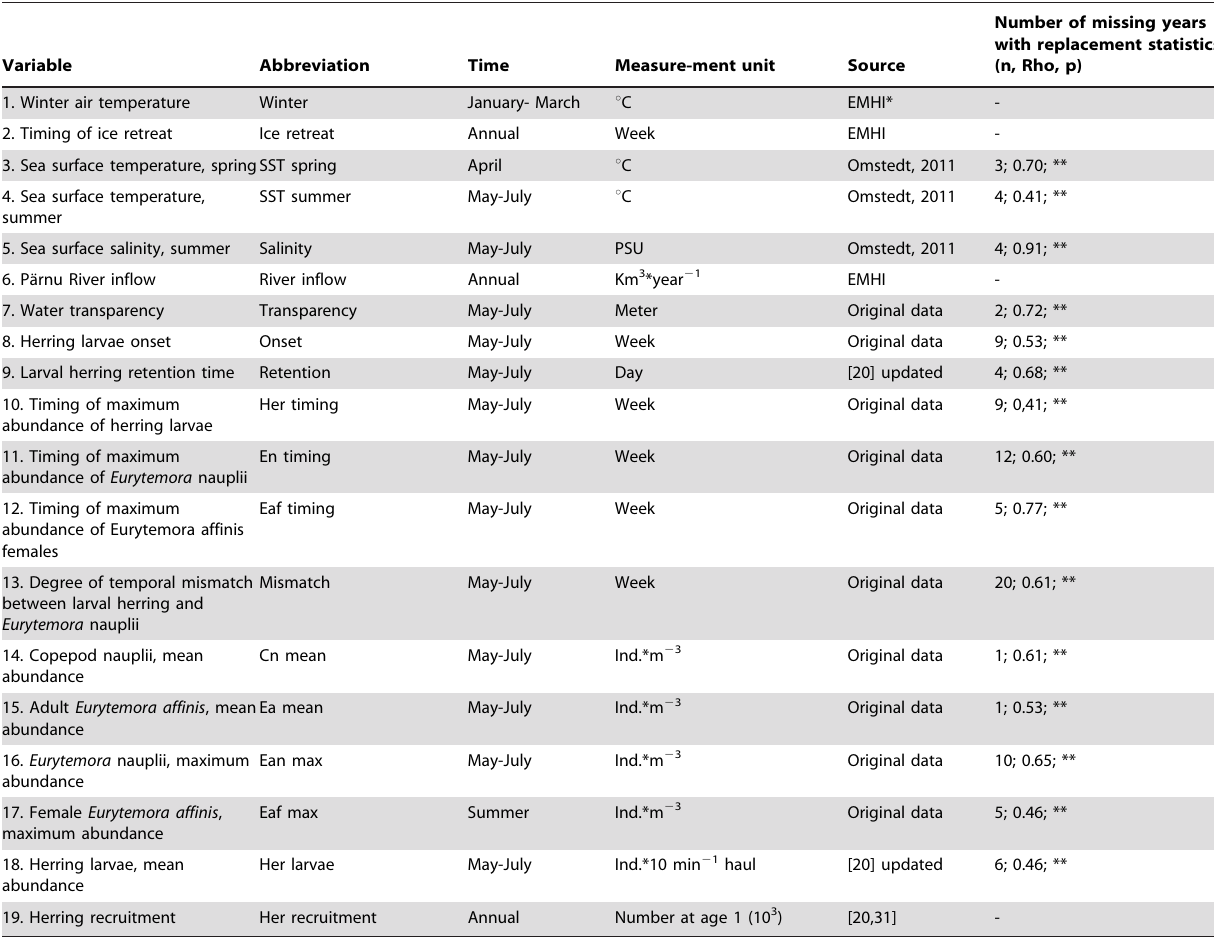
Table 1. Description of time